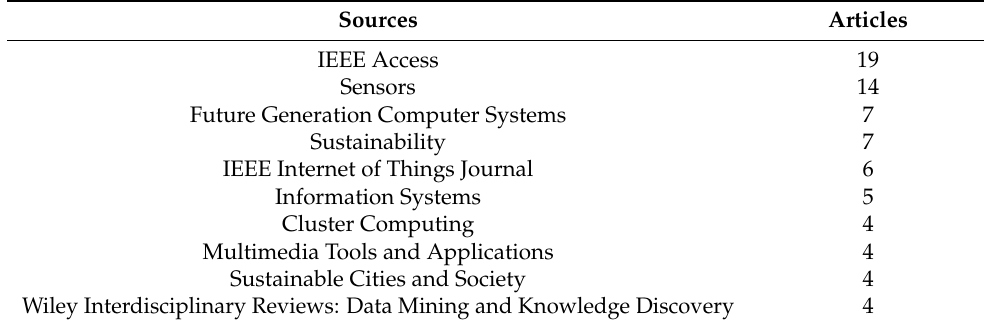
Table 3. Most relevant